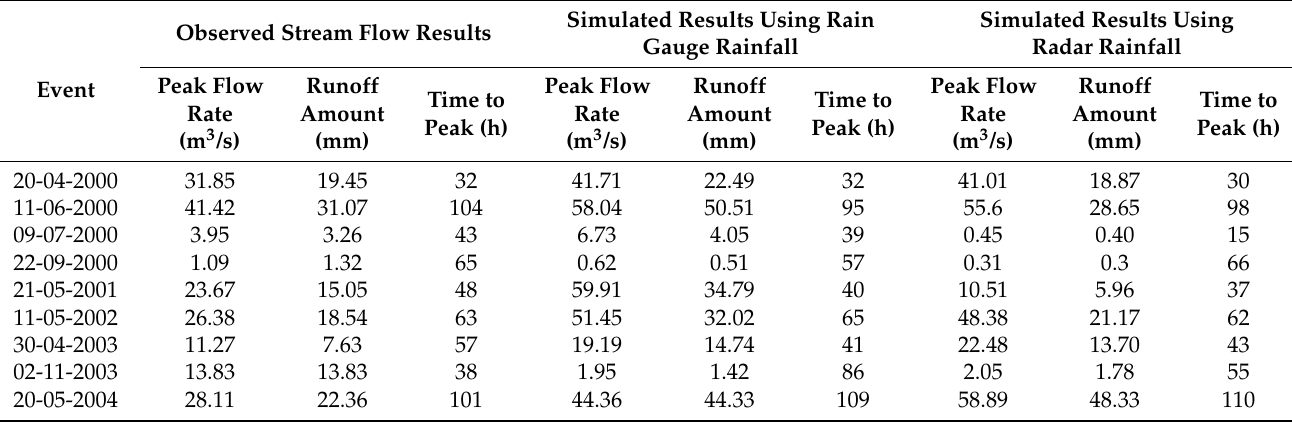
Table 2. Summary of observed and simulated peak flow rate, runoff amount, and time to peak obtained using best estimated SCS model parameters with rain gauge and radar rainfall